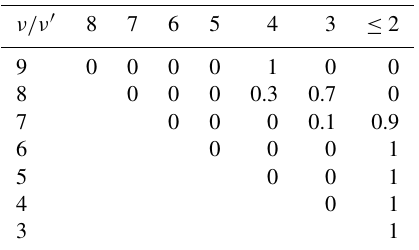
Table 2. Empirically determined branching ratios of OH( ν ) + O 2 → OH( ν (cid:48) ) + O 2 of the O 2 best-fit model based on OH(6-2) VER, OH(5-3) + OH(4-2) VER, and OH(3-1) VER